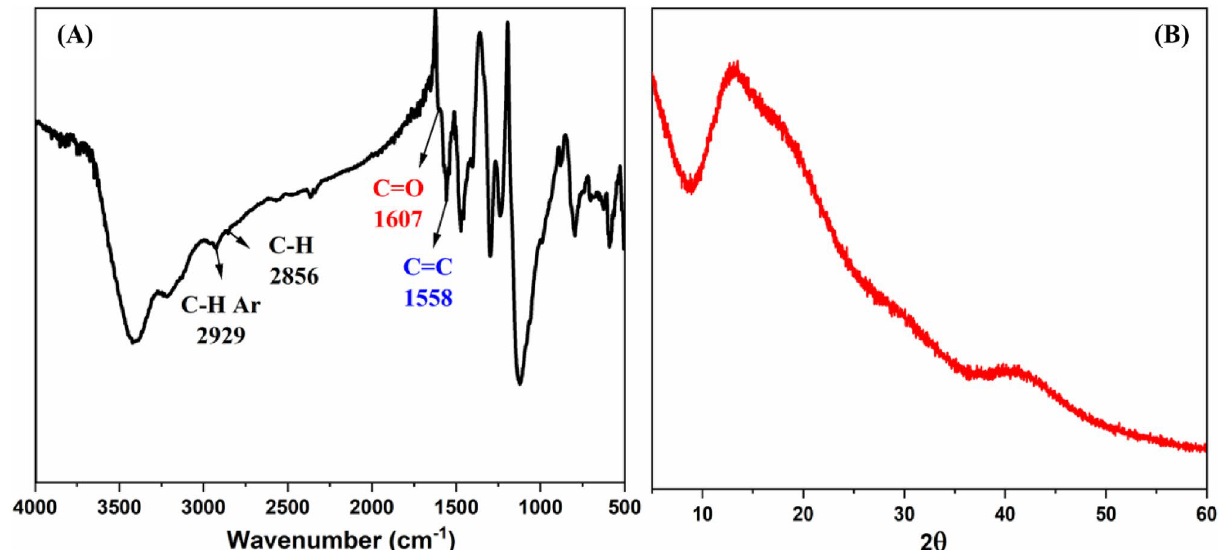
Figure 2. ( A ) FT-IR spectrum, ( B ) X-ray graph of